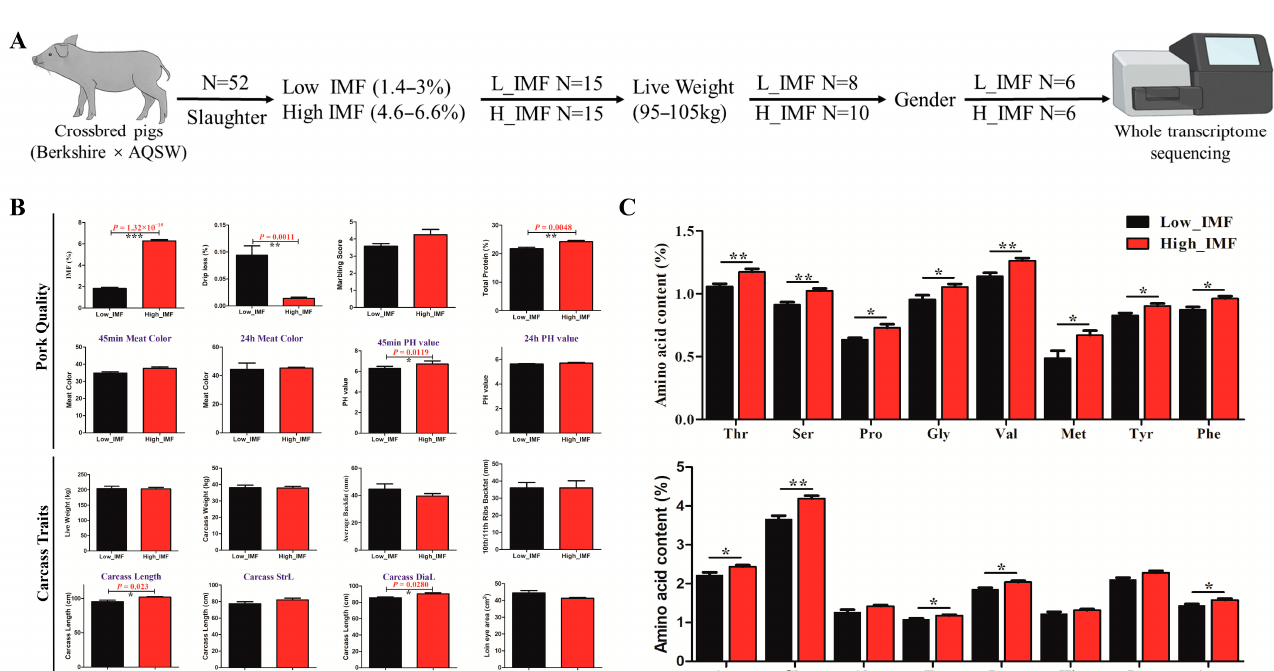
Figure 1. High/low IMF sample selection and multiple phenotype (pork quality and carcass traits) measure in crossbred pigs (Berkshire × AQSW). ( A ) Schematic diagram of six high/low IMF samples selected from 52 crossbred pigs (Berkshire × AQSW). ( B ) The summary of phenotype measure in pork quality and carcass traits between six high- and low-IMF samples (Berkshire × AQSW). ( C ) The phenotype measure summary of 16 essential amino acids between six high- and low-IMF samples (Berkshire × AQSW); * p < 0.05; ** p < 0.01.